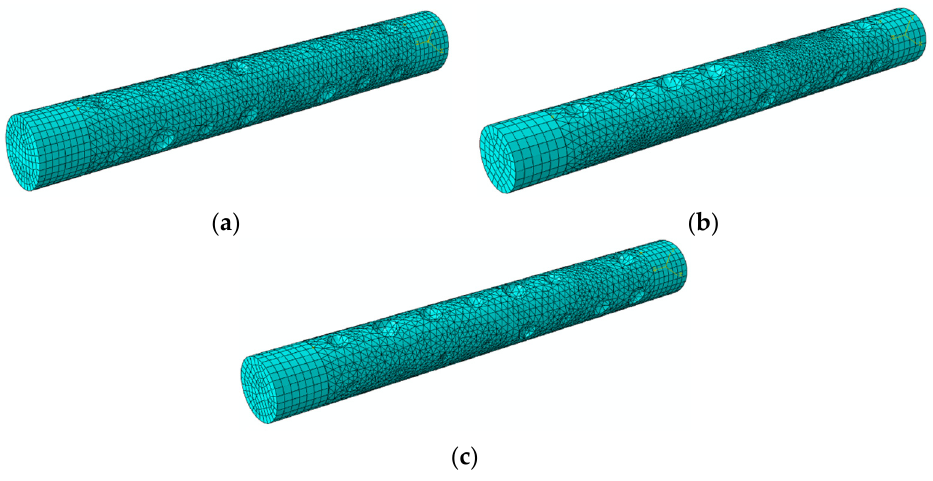
Figure 12. FEA models with different pit distributions based on Table 8: ( a ) R a ‐ 1; ( b ) R a ‐ 2; ( c ) R a ‐ 3.